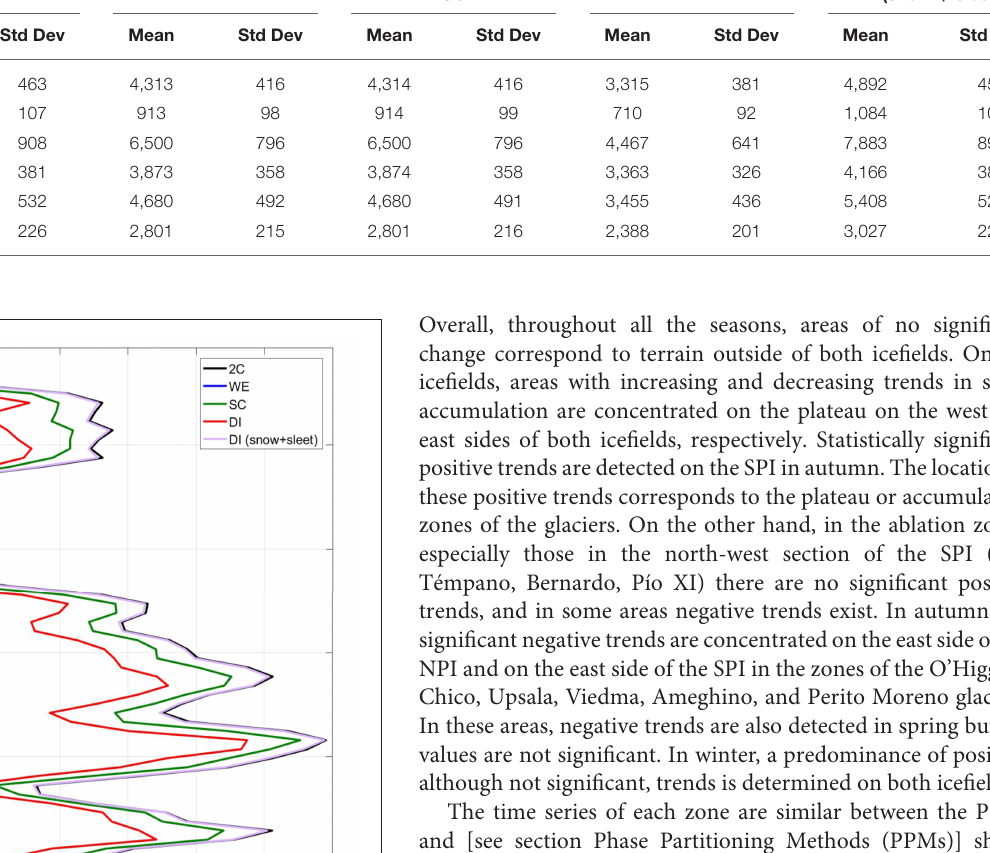
TABLE 2 | Annual mean and standard deviation 1980–2015 of the snow accumulation values by zone and PPM. Zone 2C WE SC